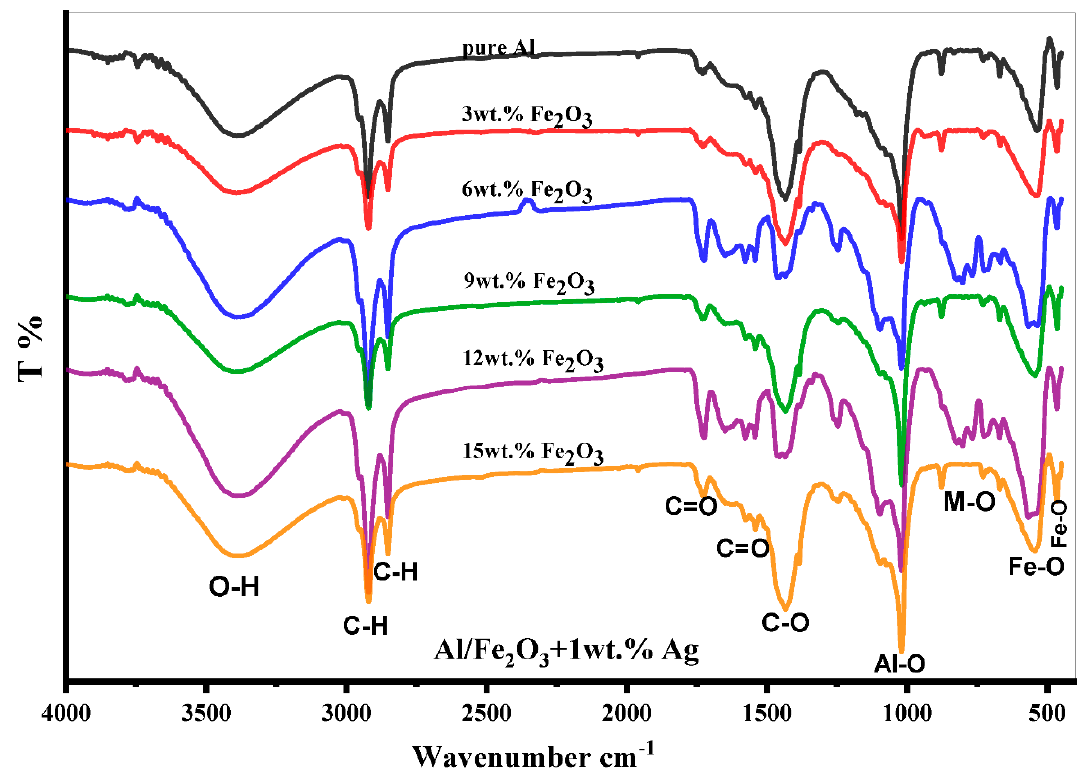
Figure 6. FTIR spectra of pure Al and Al/Fe 2 O 3 + Ag hybrid nano ‐ composites.